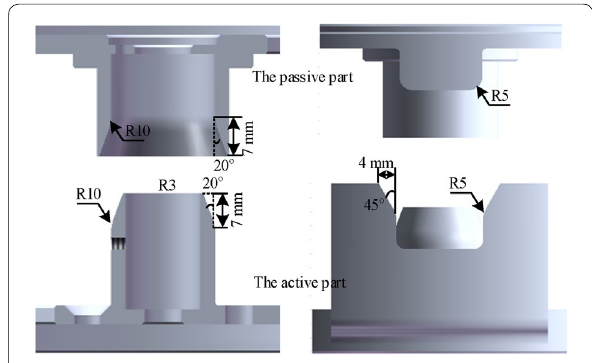
Figure 16 Structure of RCM based on